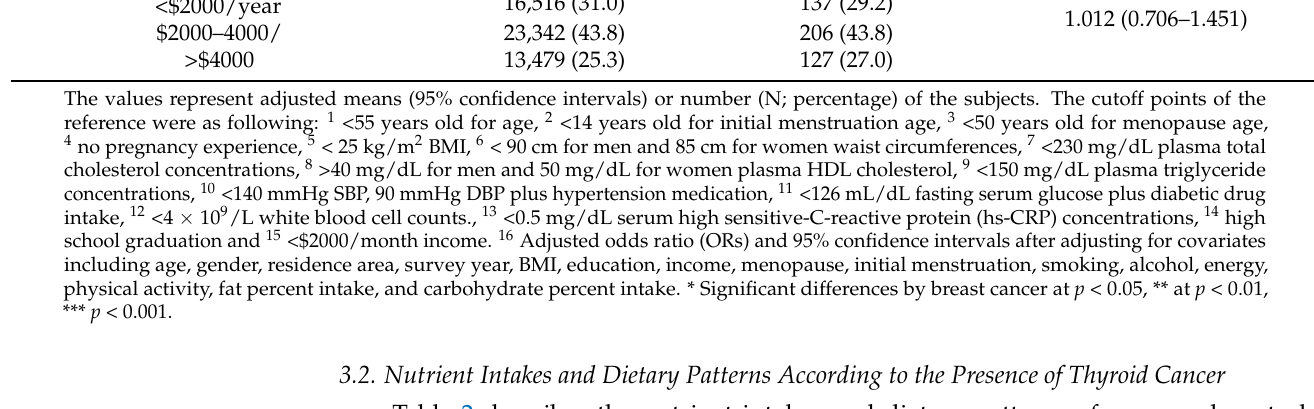
Table 2 describes the nutrient intakes and dietary patterns of cases and controls. Carbohydrate, protein, fat percent intake ( p = 0.01), exercise ( p < 0.05), smoking, alcohol, and coffee intake ( p < 0.001), but not energy and cholesterol intakes, were significantly different between the case and control groups (Table 2). Carbohydrate intake and exercise were positively associated with thyroid cancer by 1.37- and 1.06-fold, respectively, but alcohol and coffee intakes were negatively associated by 0.61- and 0.77-fold, respectively. PCA analysis of dietary patterns showed cases had a prudent diet pattern more than controls and consumed a noodle/meat diet pattern ( p < 0.001) and Korean balanced diet patterns ( p = 0.01) less than the control (Table 2). These findings may be associated with reducing smoking and alcohol and coffee consumption, increasing carbohydrate intake and exercise and changing dietary patterns after a thyroid cancer diagnosis. A high noodle/meat diet was negatively associated with the presence of thyroid cancer ( p < 0.01), but a prudent diet was positively associated with thyroid cancer ( p < 0.01). It may have been associated with switching from a noodle/meat diet to a prudent diet after receiving a thyroid cancer diagnosis. A traditional balanced diet and a rice-based diet were not associated with thyroid cancer (Table 2). Table 2. Nutrient intake and dietary patterns of the participants according to thyroid cancer